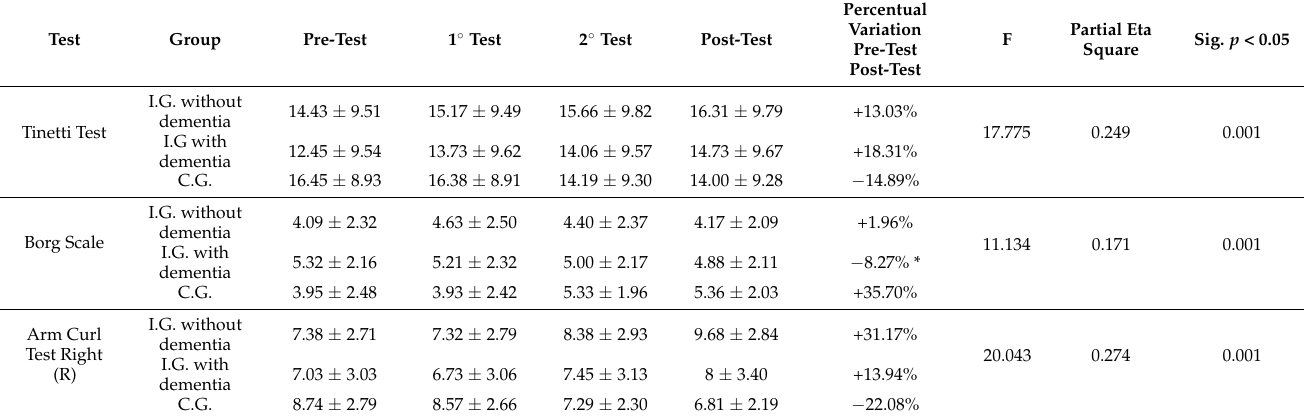
Table 2. Analysis of variance testing the effect of 1 year lifestyle intervention on all the outcome